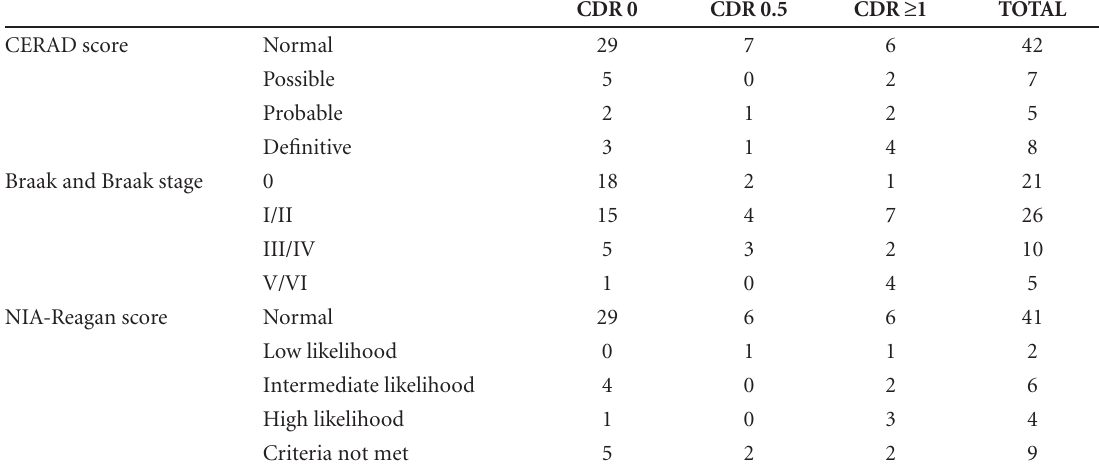
Table 3. Distribution of the cases in each CDR group by the CERAD score, Braak and Braak stage and NIA-Reagan score.